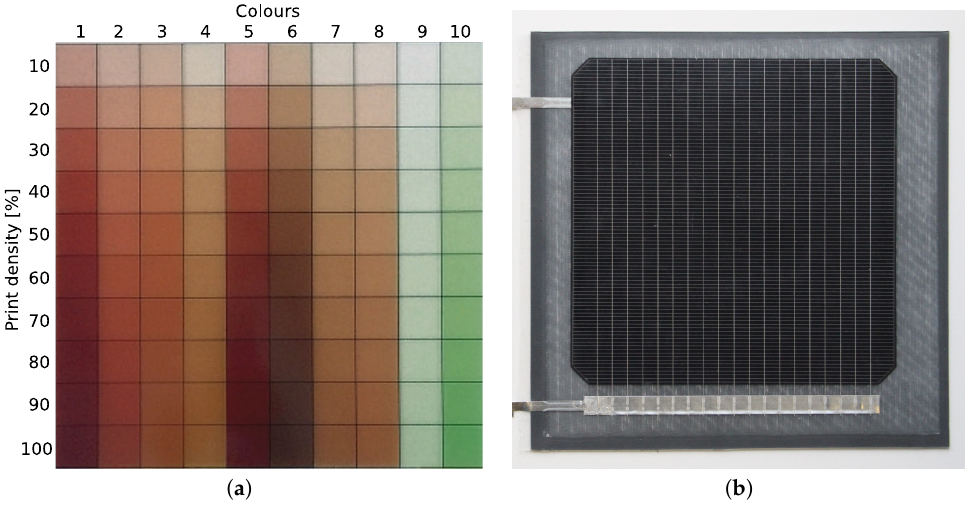
Figure 2. Sample printed glass panel with unknown candidate colours ( a ) and single-cell monocrystalline PV module ( b ) used for our matching method. Each column on the printed glass bears a unique colour, whose print density is varied per row in 10% increments. Two sets of glass panels were printed with ink volumes of 10 and 20 pl. Note this depiction is not to scale; the PV module is ca. 1 the size of the glass panel (see Figure 3 for relative sizes). 4